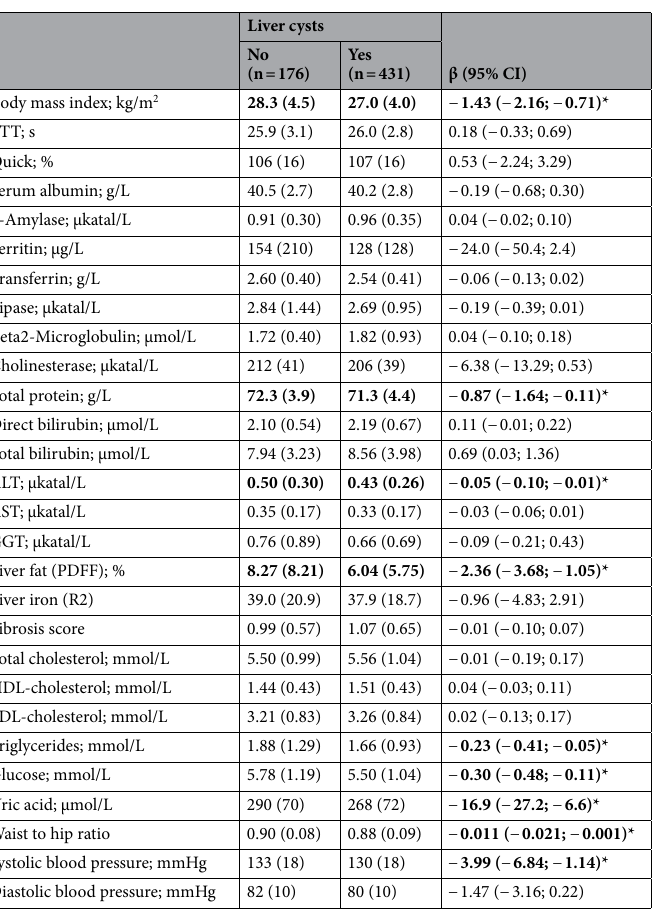
Table 1. Associations of selected laboratory markers from and MRI with liver cyst occurrence Data are expressed as mean and standard deviation; β’s were derived from linear regression models adjusted for age and sex with the respective marker as outcome and liver cyst occurrence as exposure. Significant results are given in bold letters. CI = confidence interval; * p < 0.05; PTT – partial thromboplastin time; ALT – alanine transaminase; AST – aspartate transaminase; GGT –